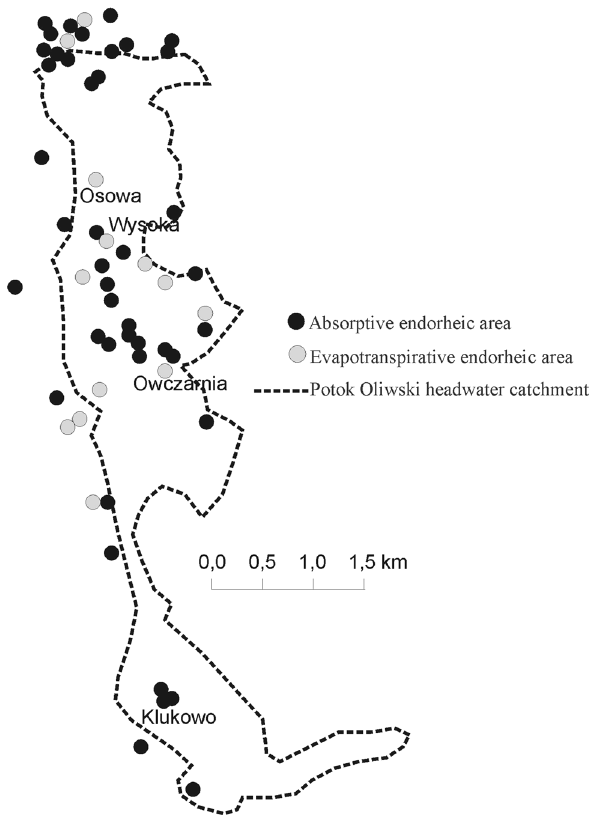
Fig. 5 Endorheic hollows of the plateau part of the Potok